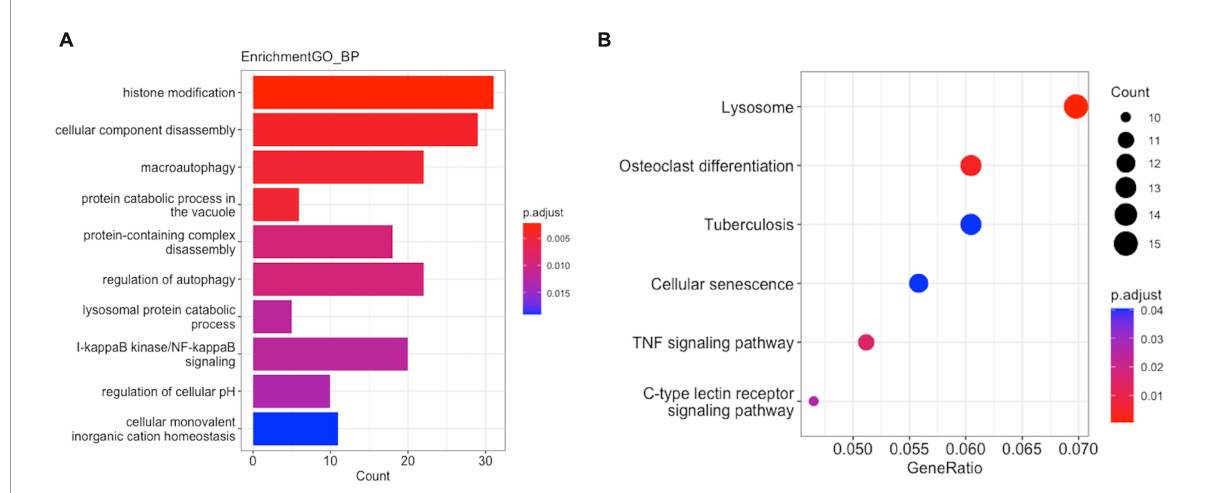
FIGURE6 Enrichment analysis of GO function and KEGG pathway in M2-related module hub genes. (A) GO analysis. (B) KEGG analysis.